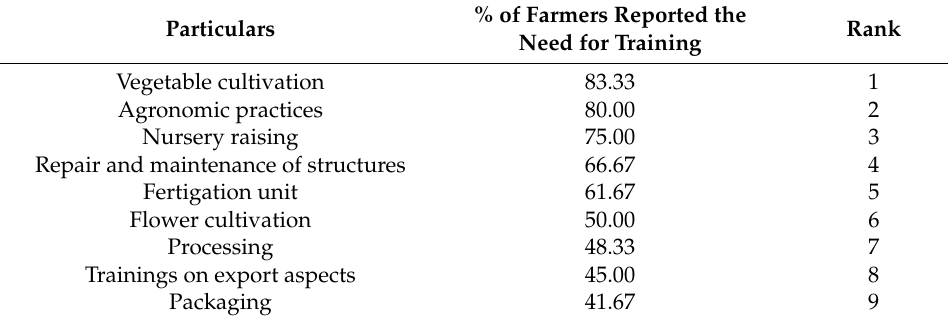
Table 22. Training needs of polyhouse